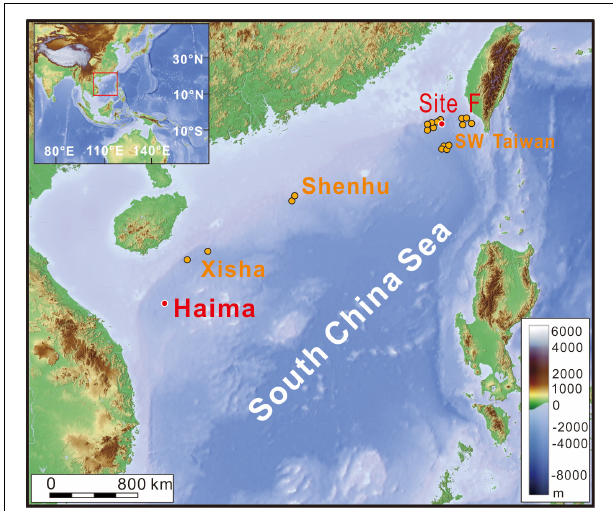
FIGURE 1 | Map showing the location of the sampling sites. Site F and Haima are active methane seeps (highlighted by red circles); orange circles indicate inactive methane seeps on the northern and western continental slope of the South China